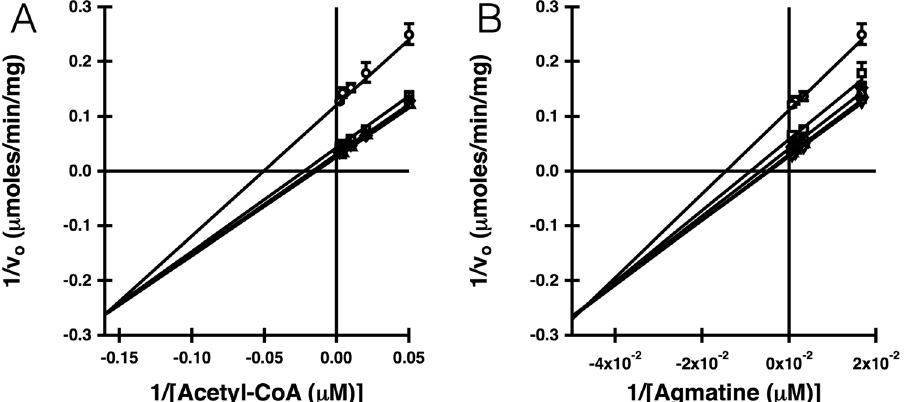
Figure 4. Acetyl-CoA and agmatine initial velocity double reciprocal plots. ( A ) Velocities measured at fixed concentrations of agmatine: 1500 μ M ( ○ ), 750 μ M ( □ ), 300 μ M ( ◇ ), and 60 μ M ( Δ ). ( B ) Velocities measured at fixed concentrations of acetyl-CoA: 500 μ M ( ○ ), 250 μ M ( □ ), 100 μ M ( ◇ ), 50 μ M ( Δ ), and 20 μ M ( ▽ ). These data are best fit to the rate equation for a sequential mechanism ( χ 2 is 4.6 for Equation 3) than the rate equation for a ping pong mechanism ( χ 2 is 5.0 for Equation